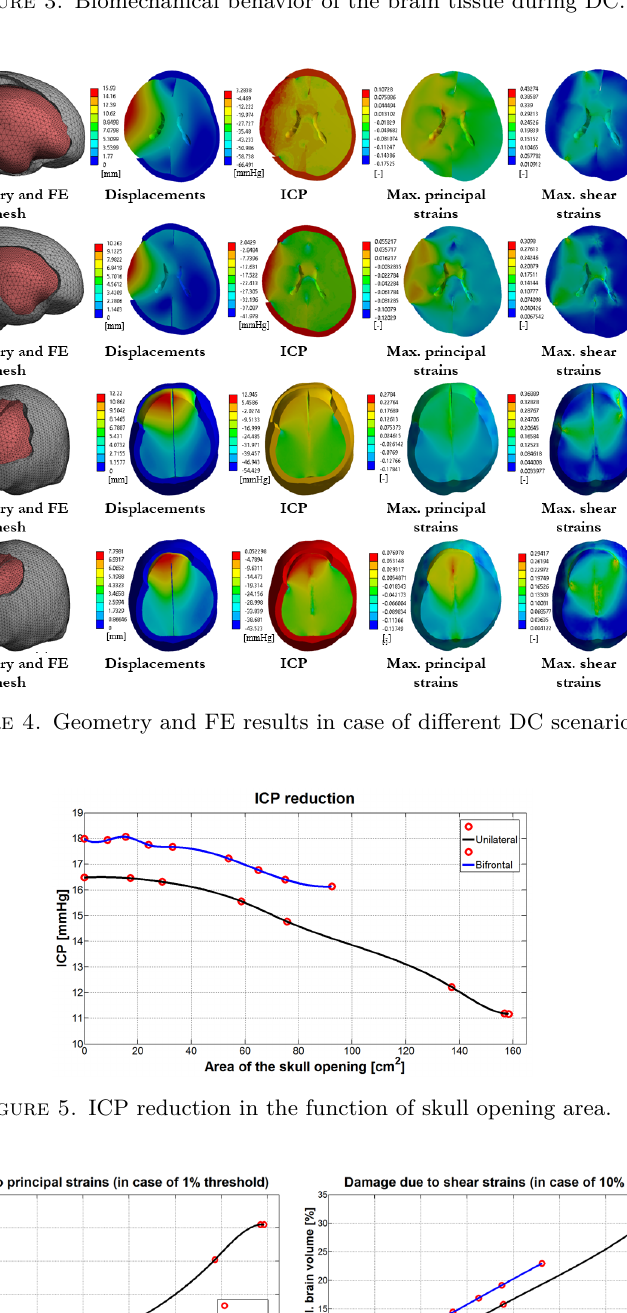
Figure 3. Biomechanical behavior of the brain tissue during DC.